Question: Write the caption for this figure.
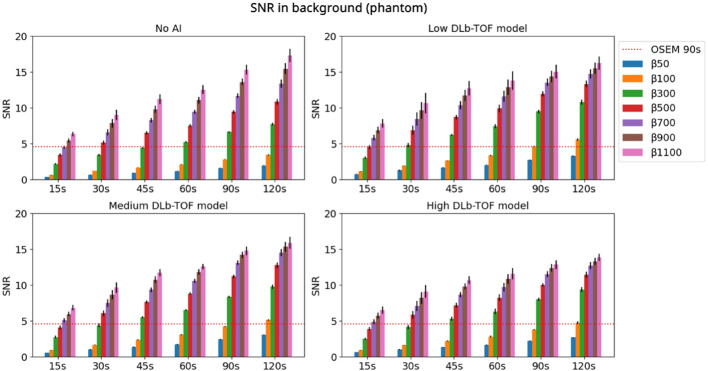
Answer: Signal-to-noise (SNR) from a homogeneous background in an anthropomorphic phantom, as a function of acquisition time and β-value without (No AI) and with the three levels of DLb-TOF model (Low, Medium and High). The dotted line represents SNR for 90 s acquisition time reconstructed with OSEM. Error bars indicate ± 1 SD